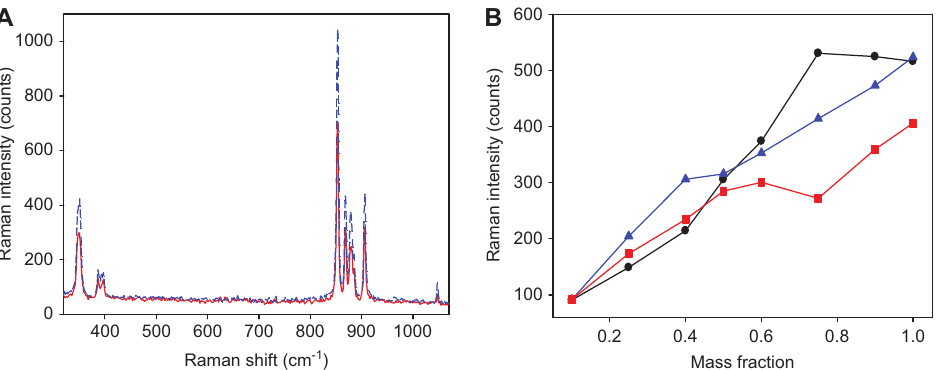
Figure 5 (A) Raman spectra of a binary powder mixture sample (potassium chromate:barium nitrate: 0.90:0.10, particle size, 425 μ m) with different compactness (blue dashed line, firmly packed; red solid line, loosely packed); (B) peak intensity at 1047.5 cm -1 vs. mass fraction of barium nitrate with different particle sizes (black circle, 180 μ m; blue triangle, 109 μ m; red square, 75 μ m). (Reprinted with permission from